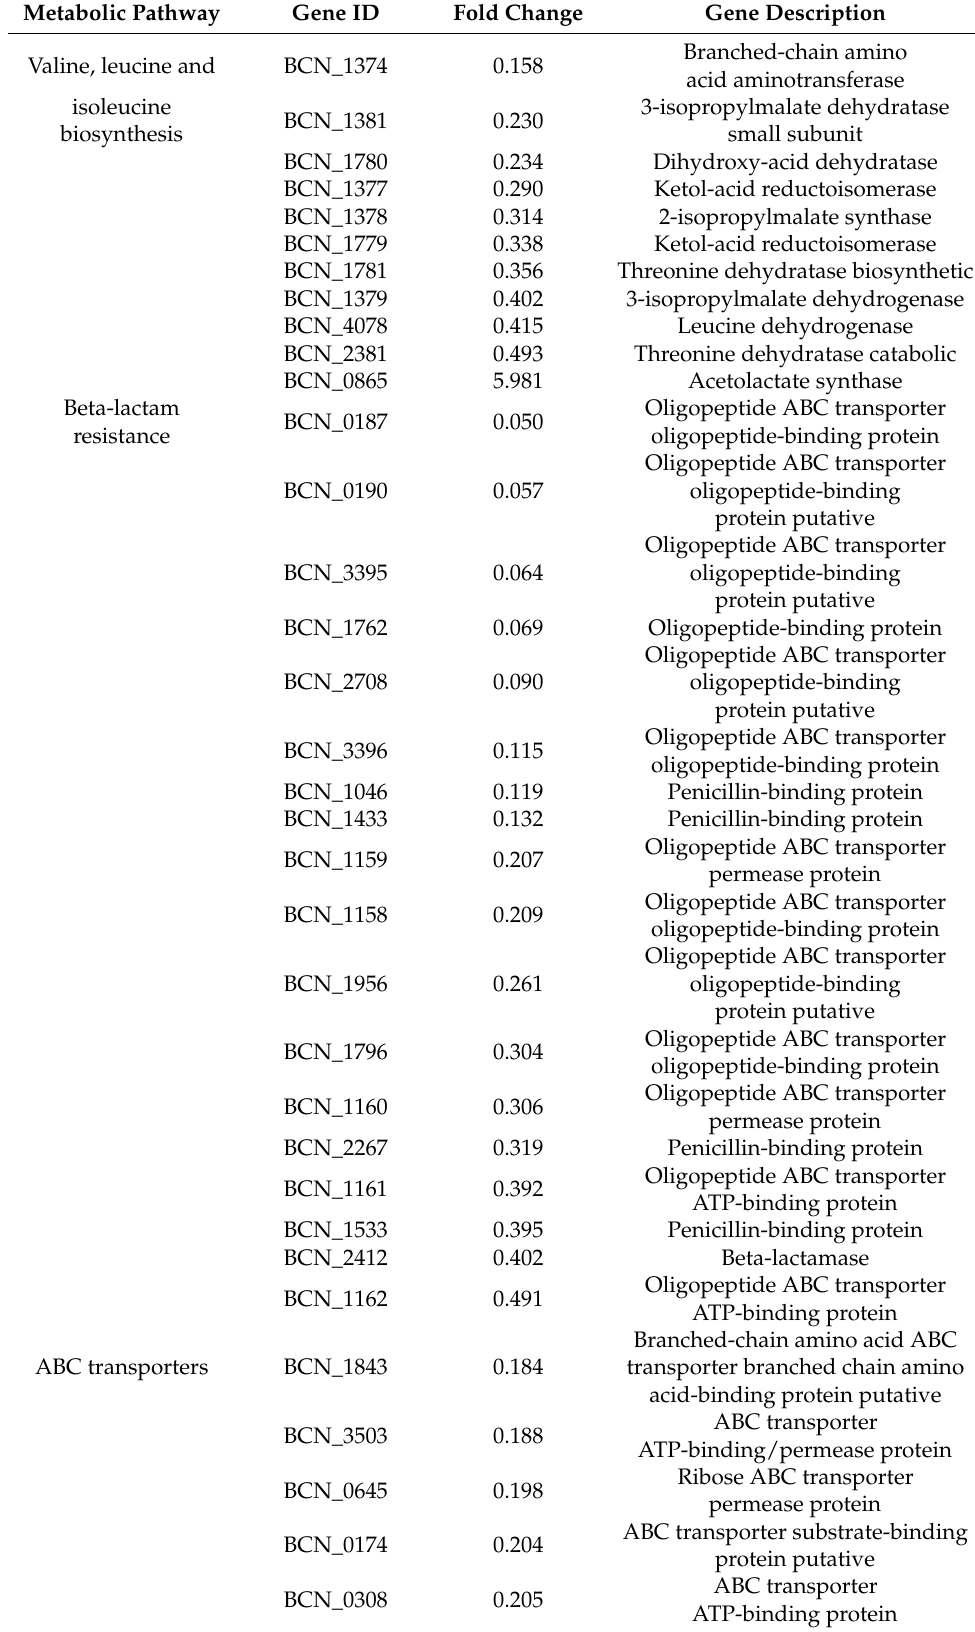
Table 6. The major altered metabolic pathways in B. cereus A1-1 mediated by Fragment 1 from C. communis Linn. Metabolic Pathway Fold